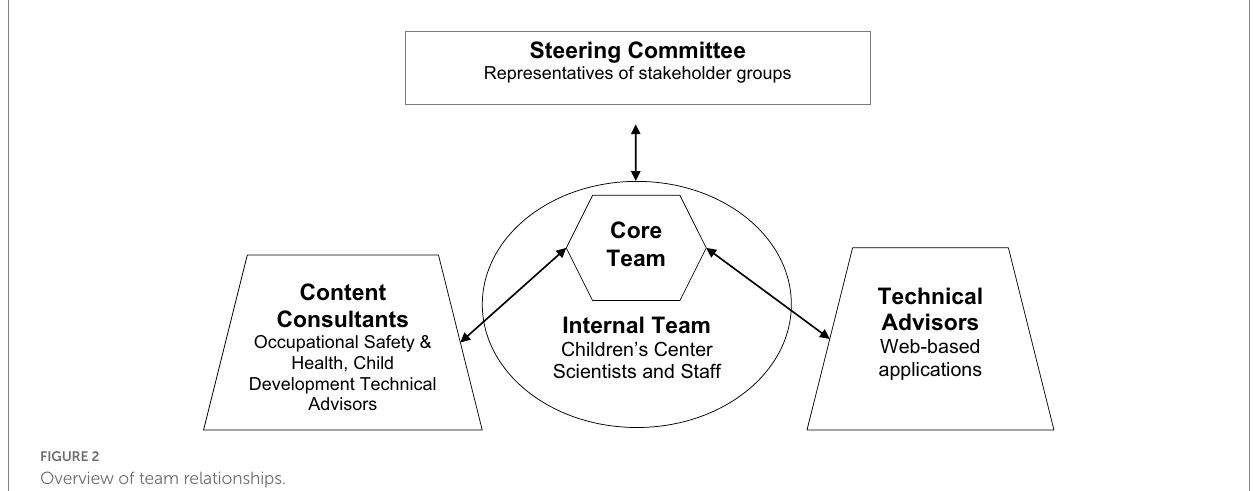
FIGURE 2 Overview of team